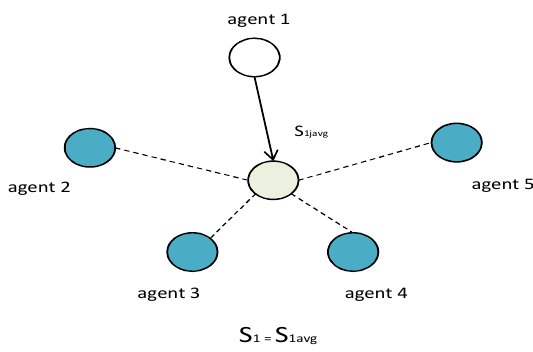
Figure 5. Calculation of S i in ECGOA arithmetic mean.